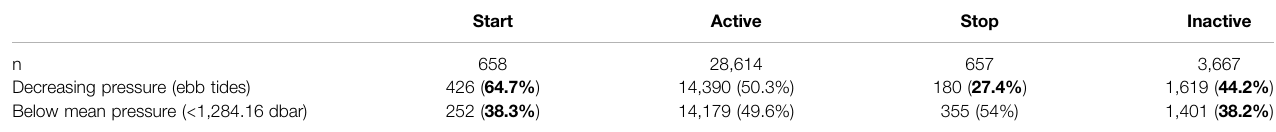
TABLE 2 | Counts of bubble emission activity phases during ebb tides (decreasing bottom pressures) and during low tides (when pressure is lower than the mean pressure recordedduringthemonitoringperiod).Ineachcolumn,thepercentagesaretheratiosofthecounts(numberofobservationsduringebbtideorduringlowtide)ton(total number of observations in each activity phase). They are not supposed to add up to 100%, as decreasing tides and low tides are neither exclusive tidal phases, nor do they represent all tidal phases. Percentage values that point to a pressure in fl uence are